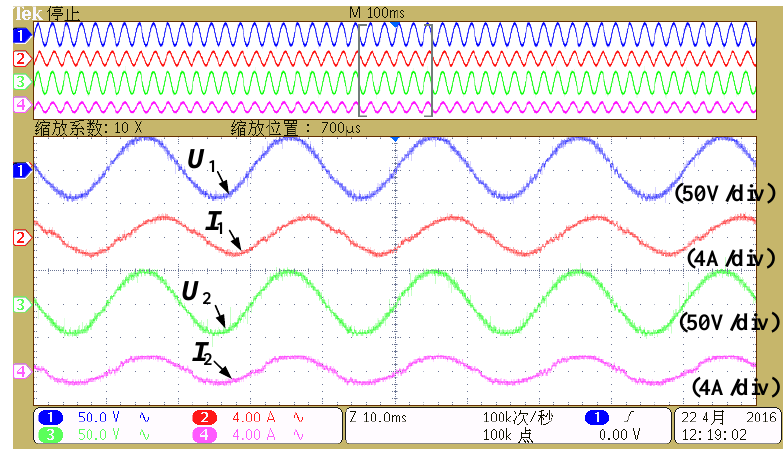
Figure 17. Steady state experimental waveforms of Case I.